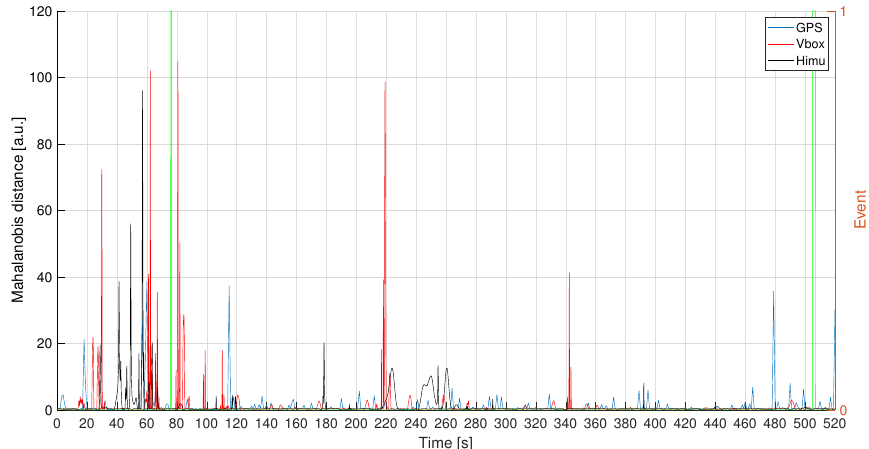
Figure 20. L1—Mahalanobis distance for the acceleration signals. Events are reported as pulsed train (green solid